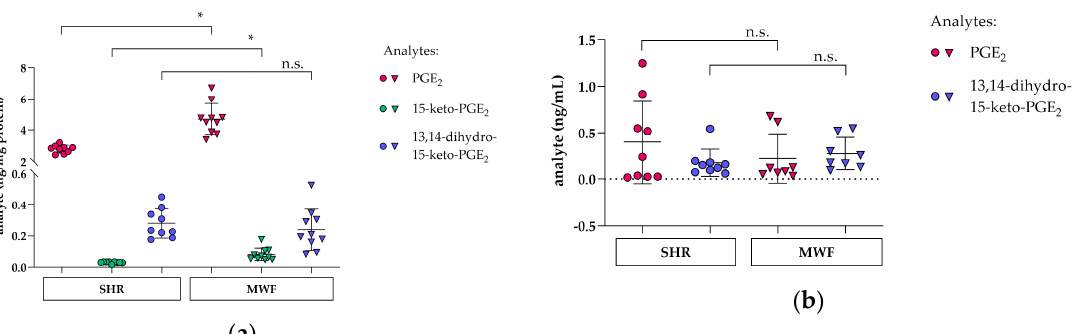
below level of detection (data not shown).